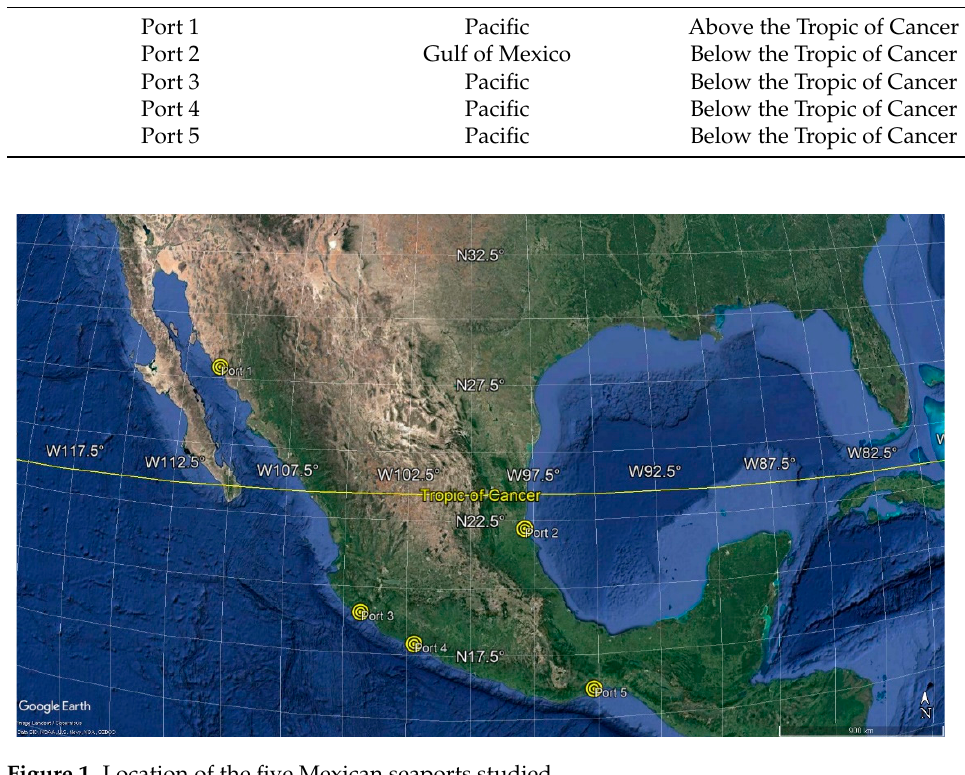
Figure 1. Location of the five Mexican seaports studied.